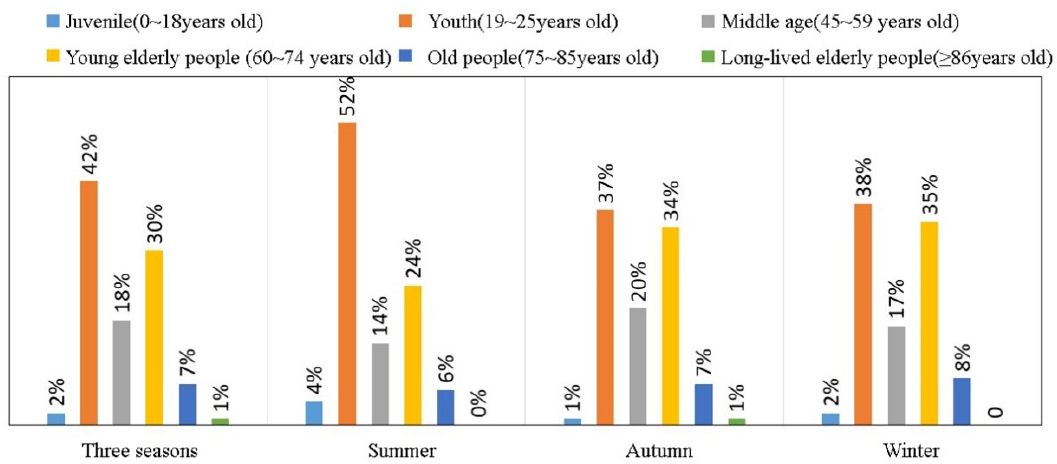
Figure 2. The age characteristics of interviewees at two squares in summer, autumn, winter, and three seasons.